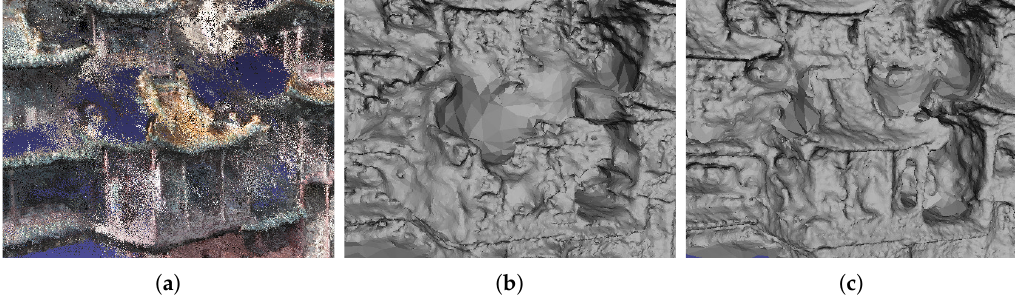
Figure 5. Surface reconstruction without and with the likelihood energy. From left to right: ( a ) point cloud with heavy noise; ( b ) reconstructed meshes without; and ( c ) with the likelihood